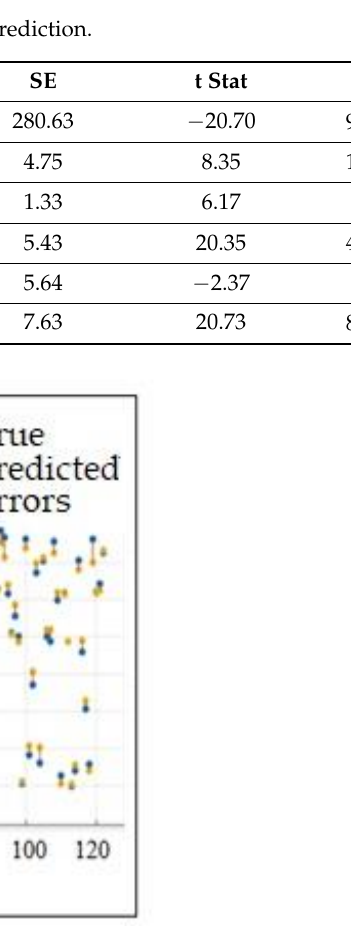
Table 4. Final regression results for irradiance prediction.